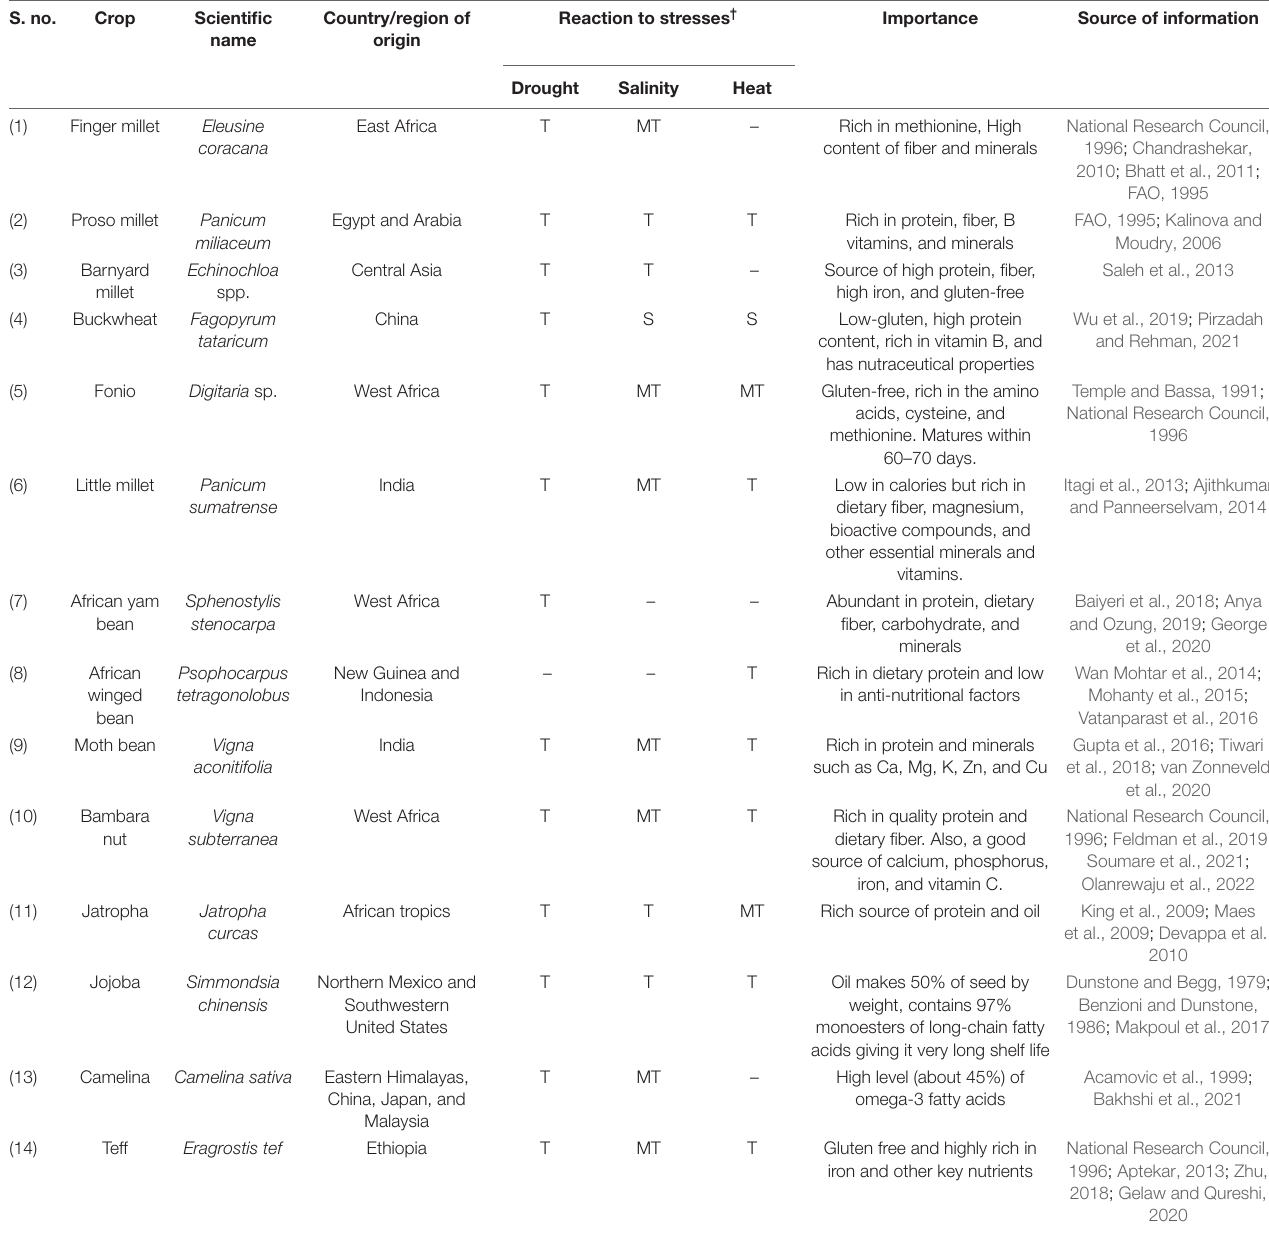
TABLE 1 | Selected nutrient-dense orphan crops for dietary diversification in marginal environments. S.